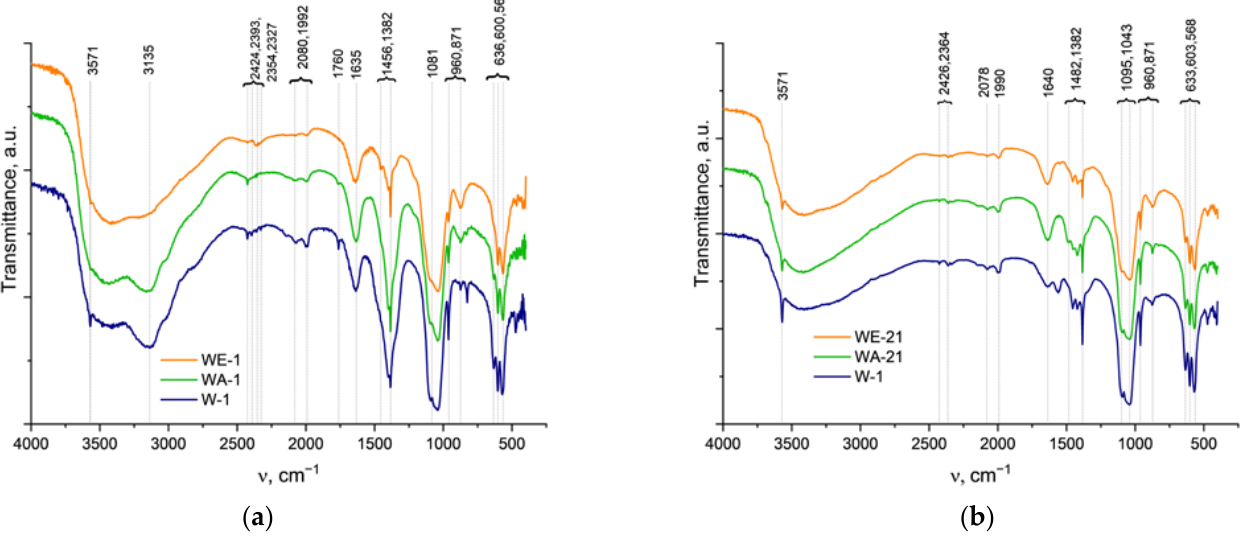
Figure 3. FTIR spectra of the as-synthesized powders ( a ), and those spectra after 21 days of ripen- ing ( b